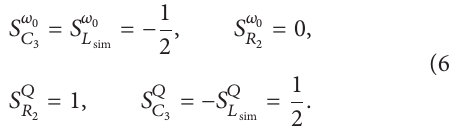
2 as resistive, and